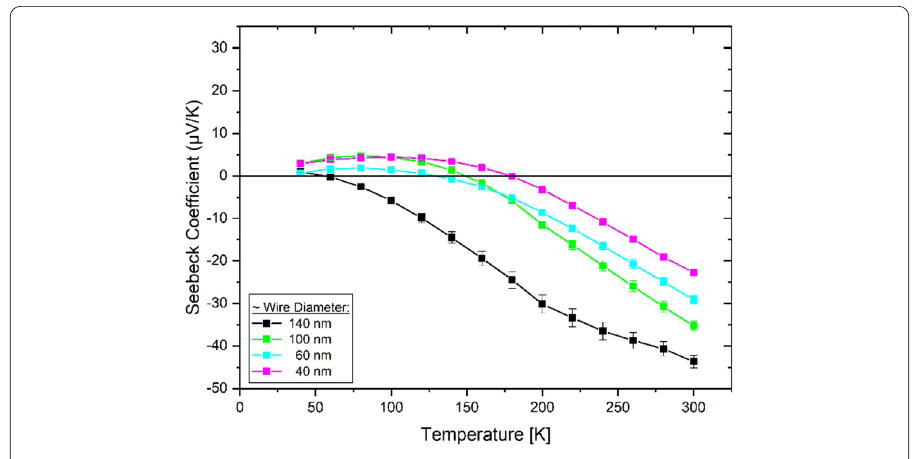
Figure 8 Seebeck coefficient of Bi nanowire networks with a wire density of 1.4 × 10 9 cm –2 as a function of temperature. From M.F.P. Wagner, PhD Thesis, Technische Universität Darmstadt,